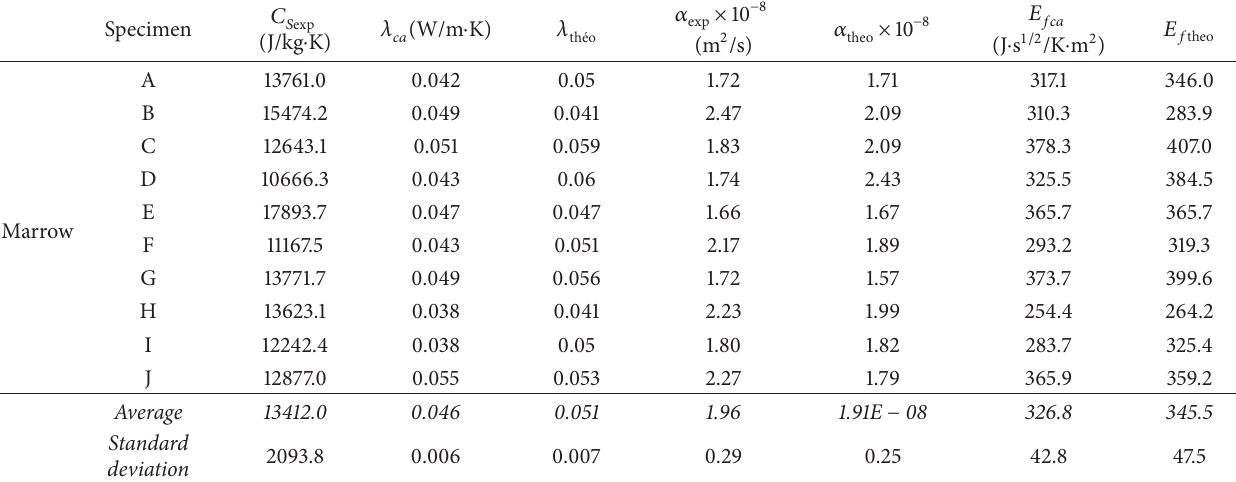
Table 5: Moisture content and densities of raffia bamboo for the tests.